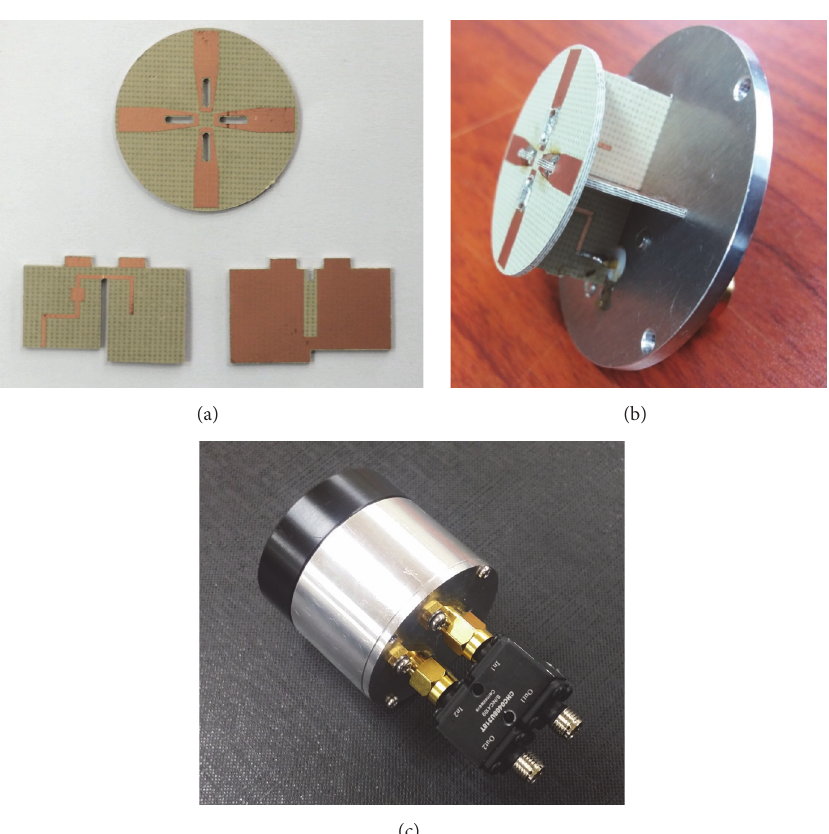
Figure 6: Fabricated feed. (a) Crossed dipoles and feed circuits, (b) crossed dipoles installed on the back short, and (c) the assembled antenna.